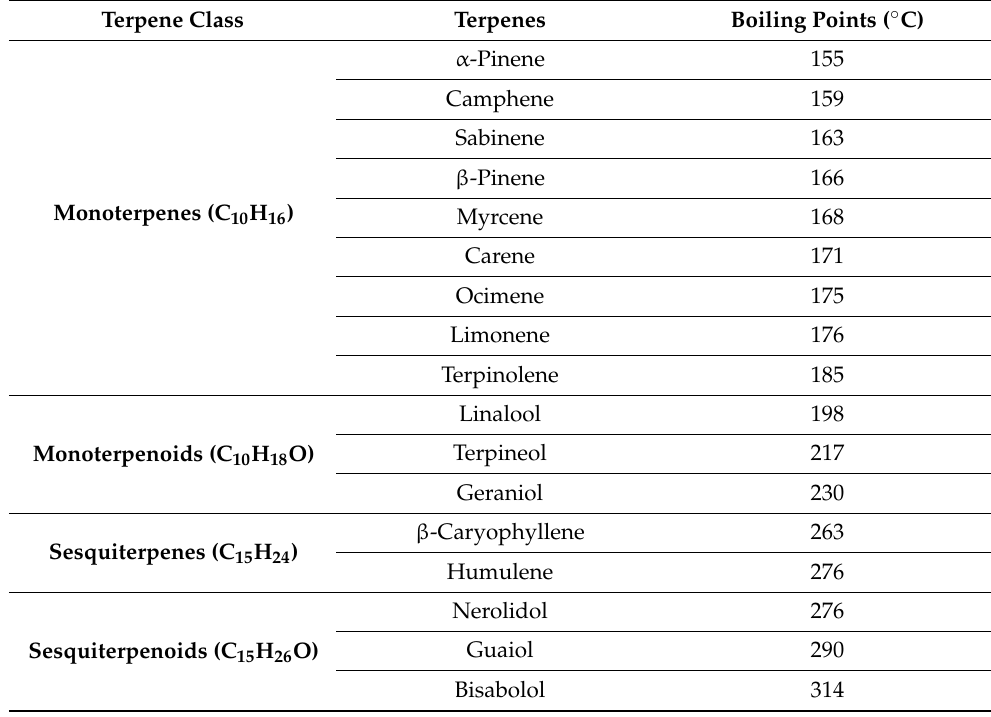
Table 1. Terpenes’